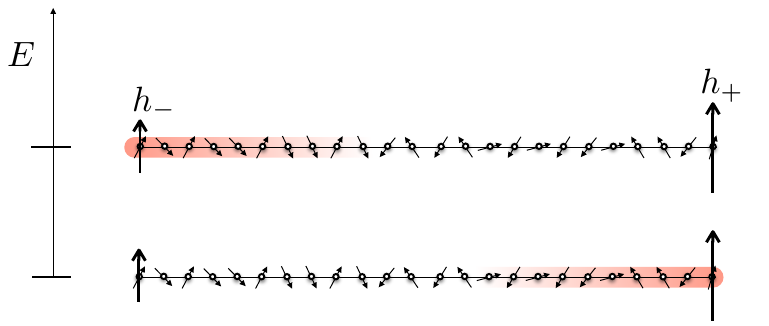
Figure 8: Pictorial representation of the ground state and the first excited state in the regime | h ± | < h ( 1 ) . The boundary root is a localized excitation (here represented cr in red) pinned, in the ground state, at the edge of the chain where the field is the largest. Here h + > h − , and the ground state has the boundary root localized around = π/ 2 − i ( ζ/ 2 − ˜ ξ ) + O ( L −∞ ) , the right edge, (with exponential tails), i.e with α + + BR while the first excited state has it localised around the left edge, i.e with = π/ 2 − i ( ζ/ 2 − ˜ ξ ) + O ( L −∞ ) α − − BR